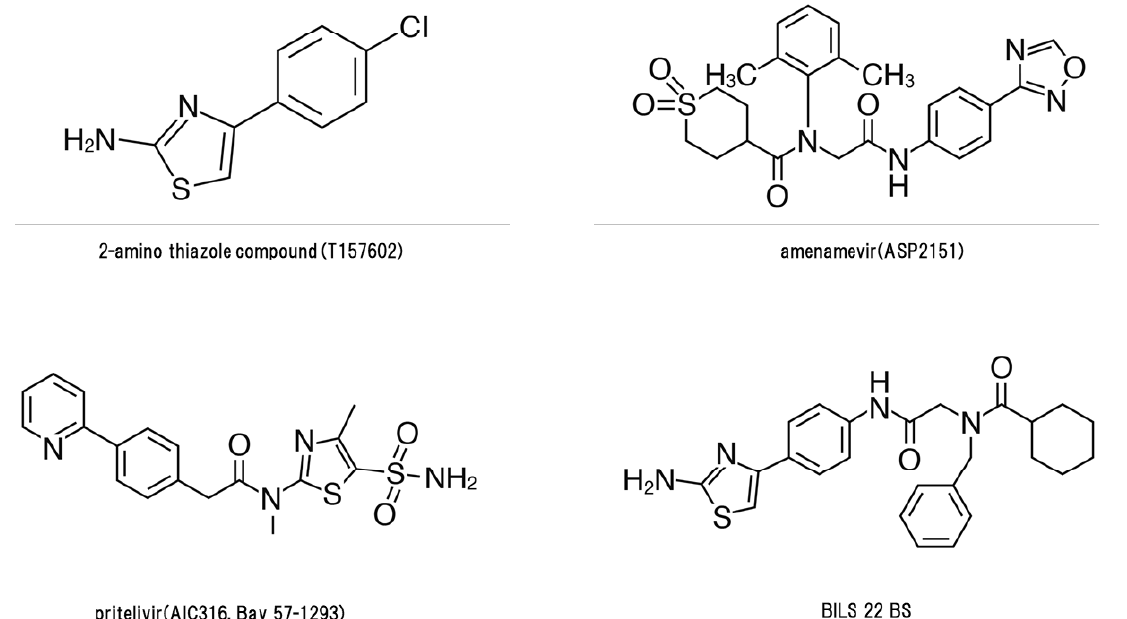
Figure 2. Structures of helicase-primase inhibitors.